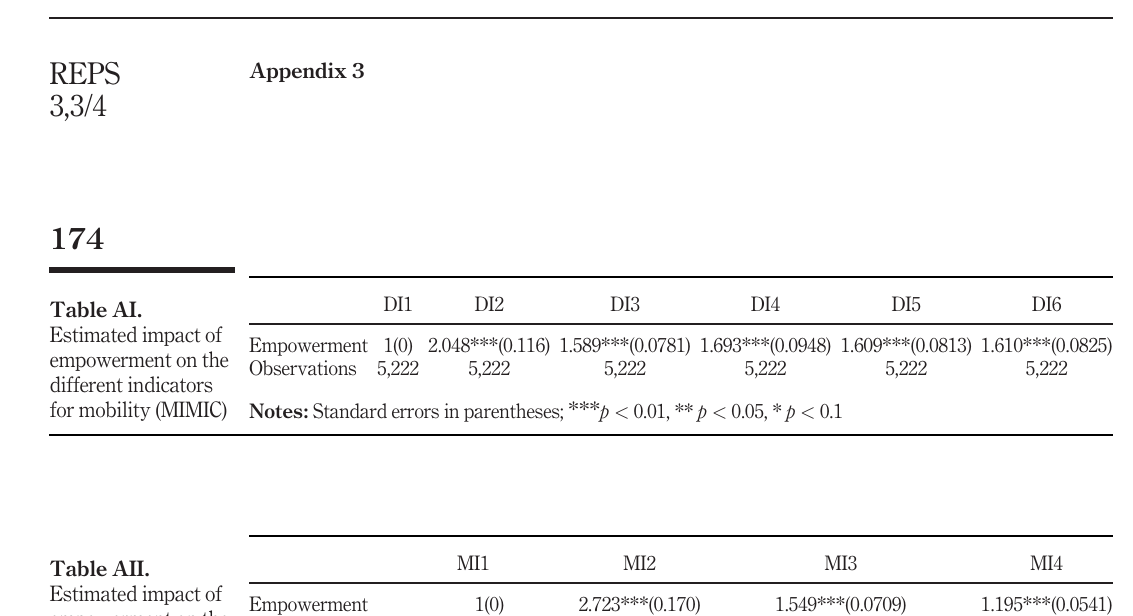
Table AII. Estimated impact of empowerment on the different indicators for mobility (MIMIC)